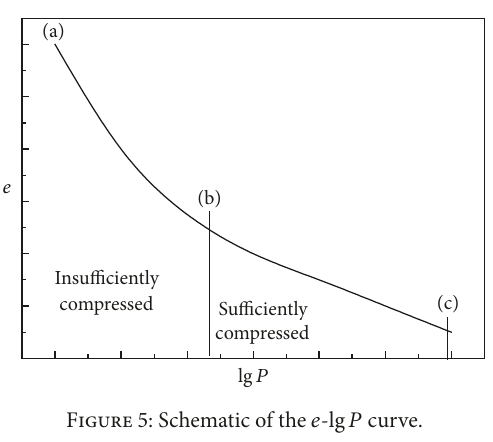
Figure 5: Schematic of the 𝑒 -lg 𝑃